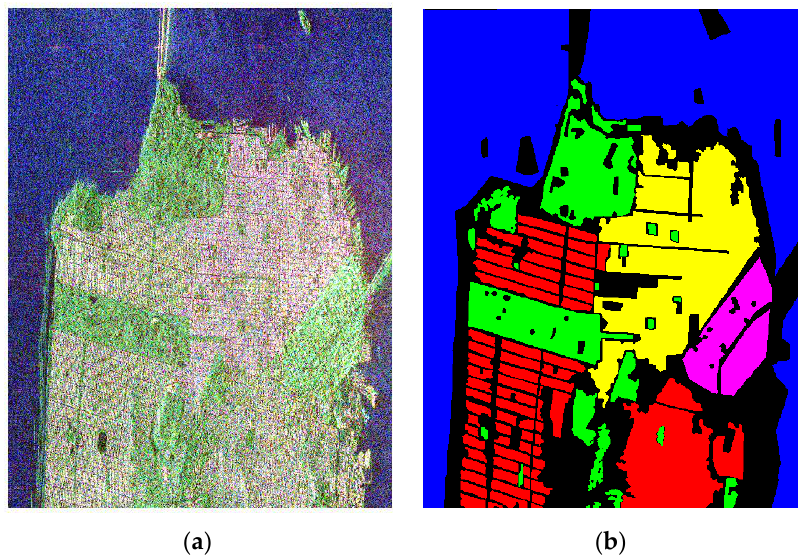
Figure 10. San Francisco PolSAR dataset and its corresponding ground truth data. ( a ) Pauli color